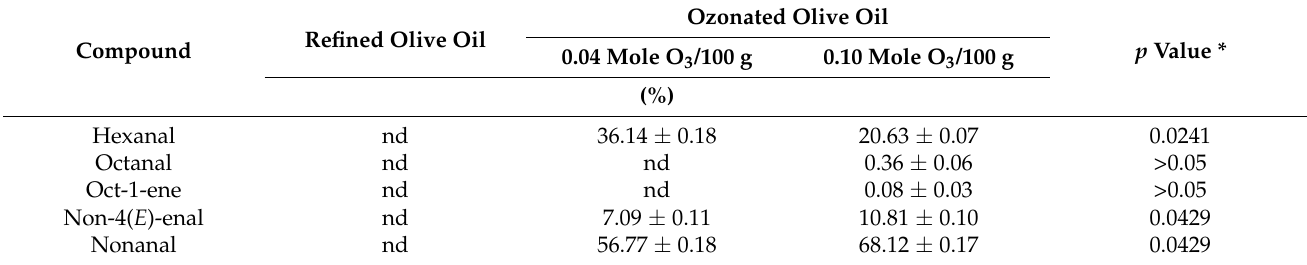
Table 2. The composition of the surface phase of olive oil depending on the ozone concentration used.